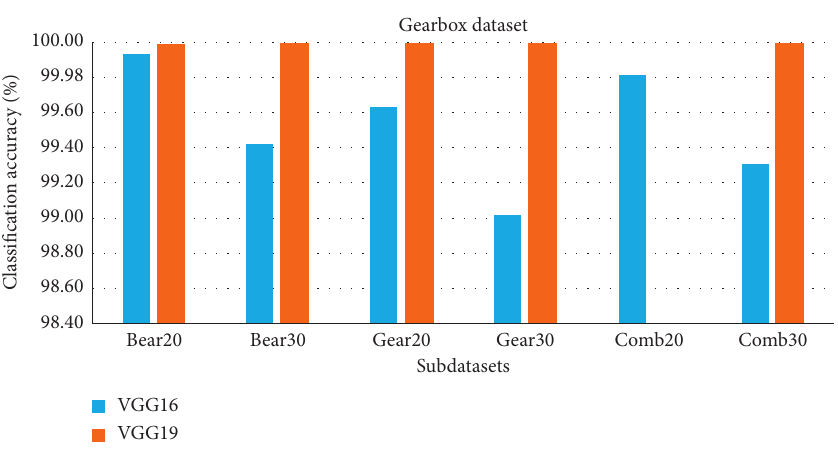
Figure 14: Classification accuracy of VGG16 and VGG19 on the gearbox